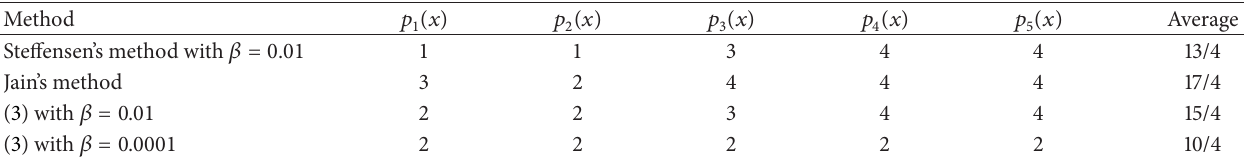
Table 4: Results of chaotic comparisons for different derivative-free